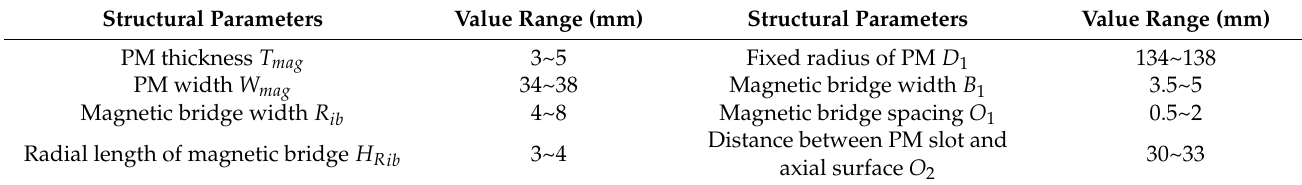
Table 2. Value range of parameters to be